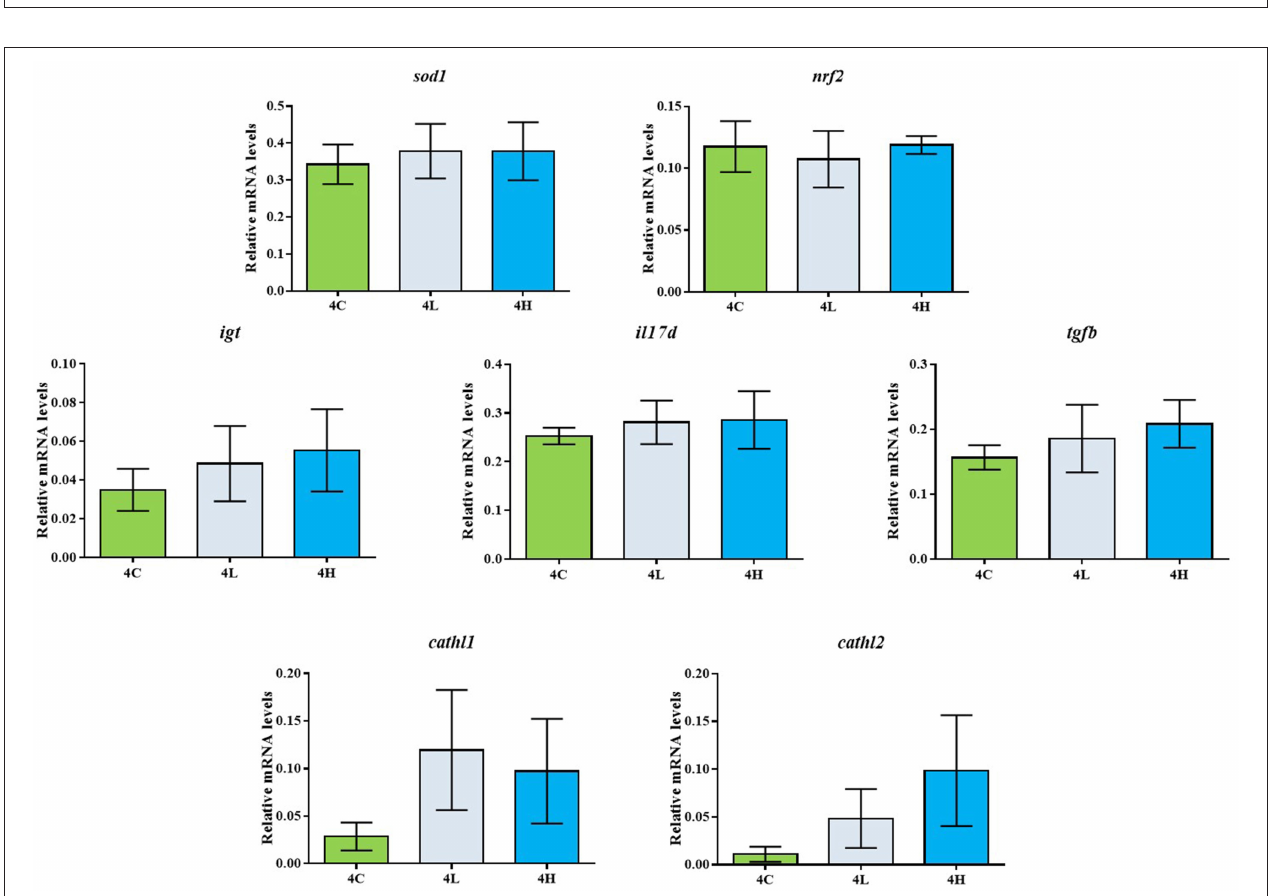
FIGURE 2 | Relative mRNA levels of sod , nrf2 , igt , il17d , tgfb , cathl1 , cathl2 in the distal intestine of Atlantic salmon from the different groups. The values are presented as mean ± s.e.m.; n = 6 tanks, 2 fish/tank.